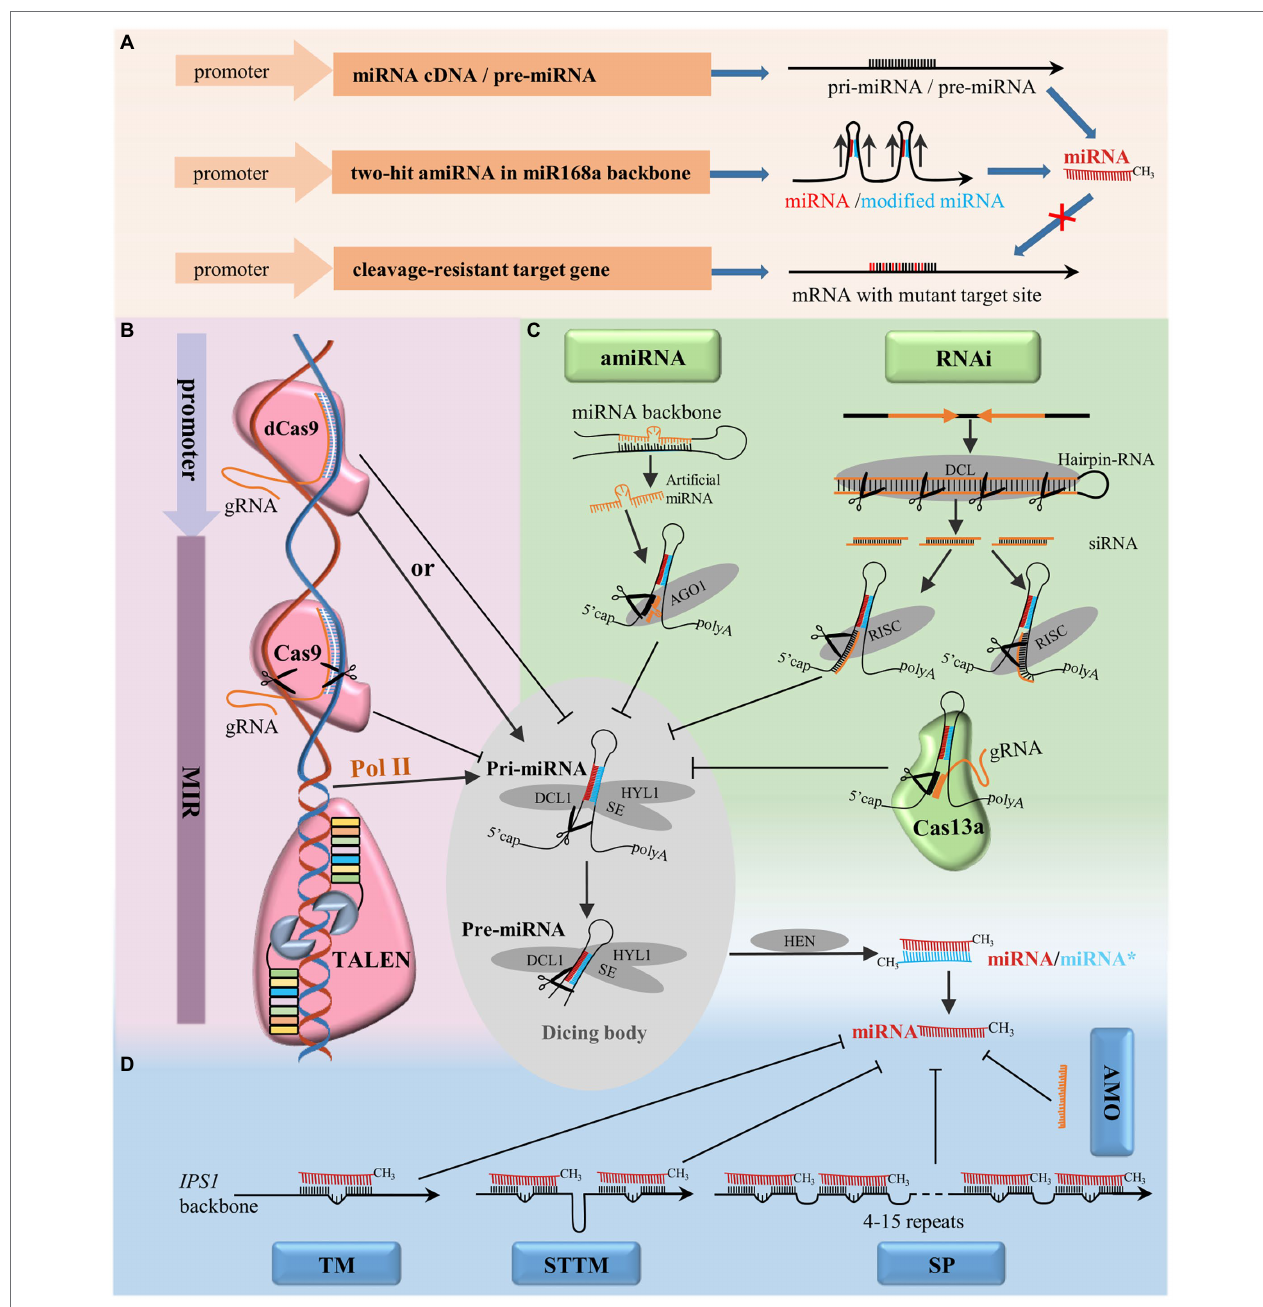
FIGURE 2 | Techniques for the functional analysis of miRNAs in plants. (A) Transgenesis strategies to identify the functions of miRNAs via gain-of-function, overexpression of miRNAs by pre-miRNA, cDNA of miRNA or amiRNA, overexpression of miRNA cleavage-resistant target genes to mimic the effect of downregulating the expression of miRNA. (B) Techniques targeting miRNA genes: CRISPR-associated nuclease 9 (CRISPR/Cas9) system and TALEN for miRNA gene editing, CRISPR/dCas9 system for transcriptional regulation by targeting the promoter region. (C) Techniques targeting pri-/pre-miRNA: RNAi, amiRNA, and the CRISPR/Cas13a system. (D) Techniques targeting mature miRNA: AMO, TM, short tandem target mimic (STTM), and SP. AGO1, ARGONAUTE1; DCL1, DICER- LIKE1; HEN1, HUA ENHANCER1; HYL1, HYPONASTIC LEAVES1; RISC: RNA-induced silencing complex; SE,